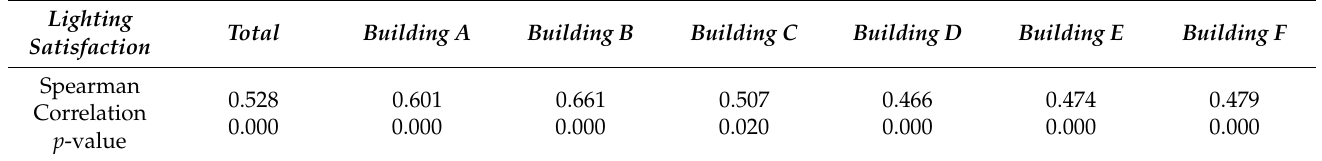
Table 2. Spearman coefficient between lighting satisfaction and lighting